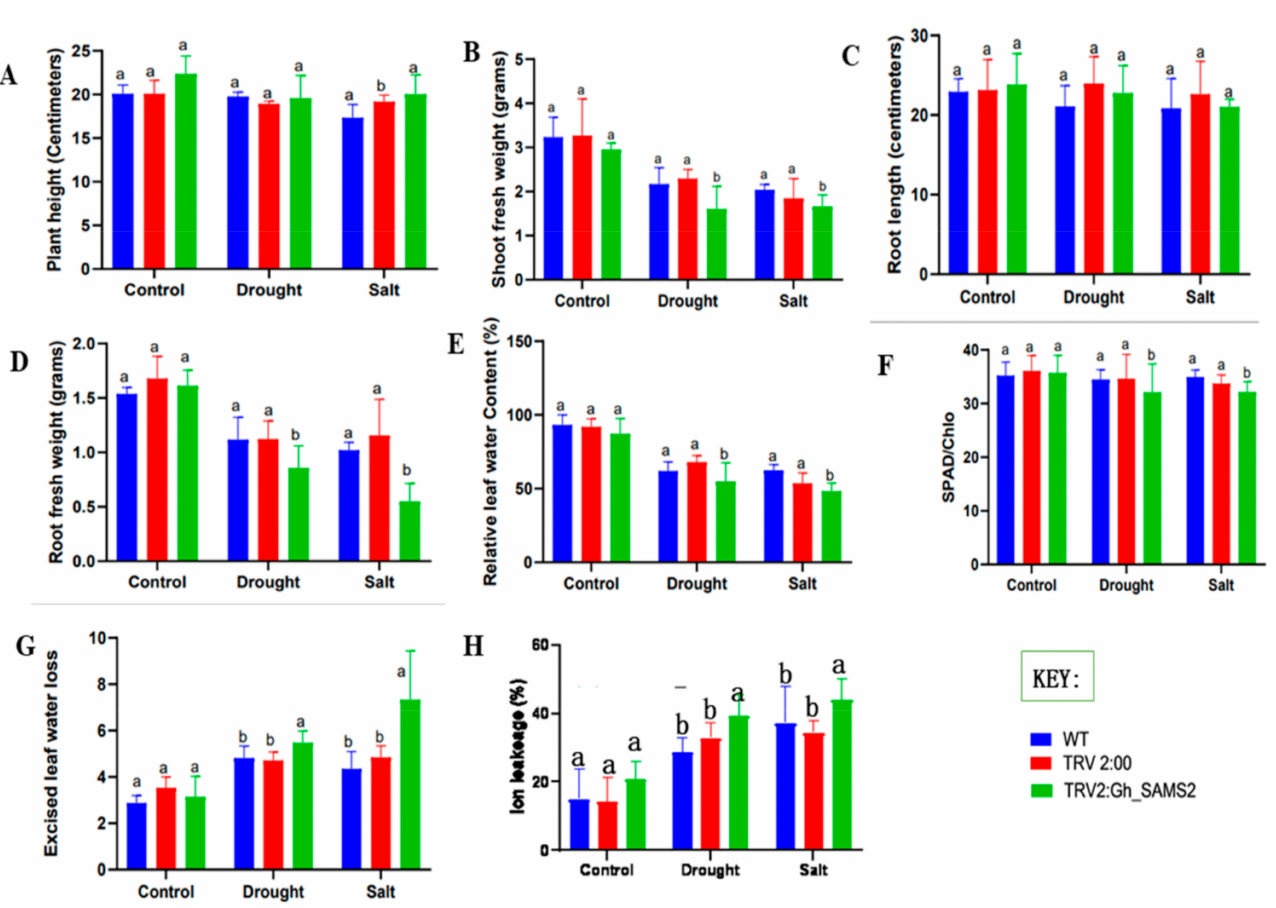
Figure 4. VIGS and WT plants’ physiological and morphological traits analyzed under the conditions of drought and salt stress. ( A ) Plant height. ( B ) Shoot fresh weight. ( C ) Root length. ( D ) Root fresh weight. ( E ) Relative leaf water content. ( F ) Leaves’ chlorophyll content. ( G ) Excised leaf water loss. ( H ) Ion leakage in the leaf. TRV2:00, Positive control; WT, Wild type; and TRV2: GhSAMS2 , VIGS plants. Different letters above the bars indicate statistically significant differences at p < 0.05.